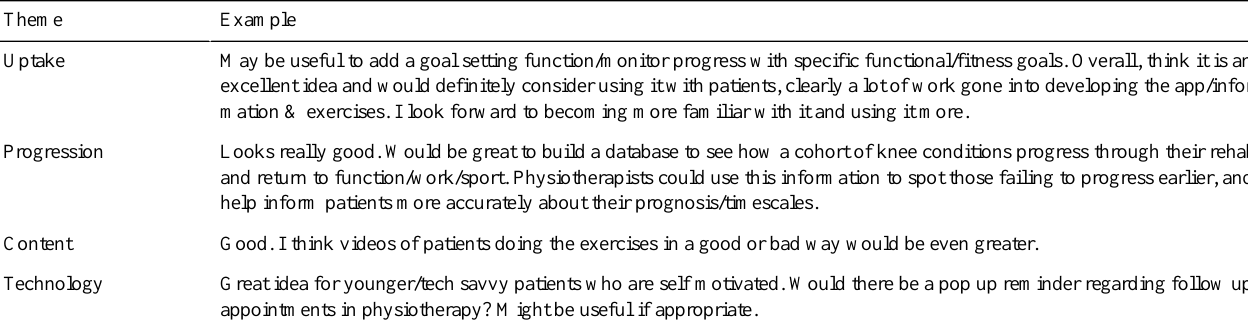
Table 4. A sample of physiotherapists'